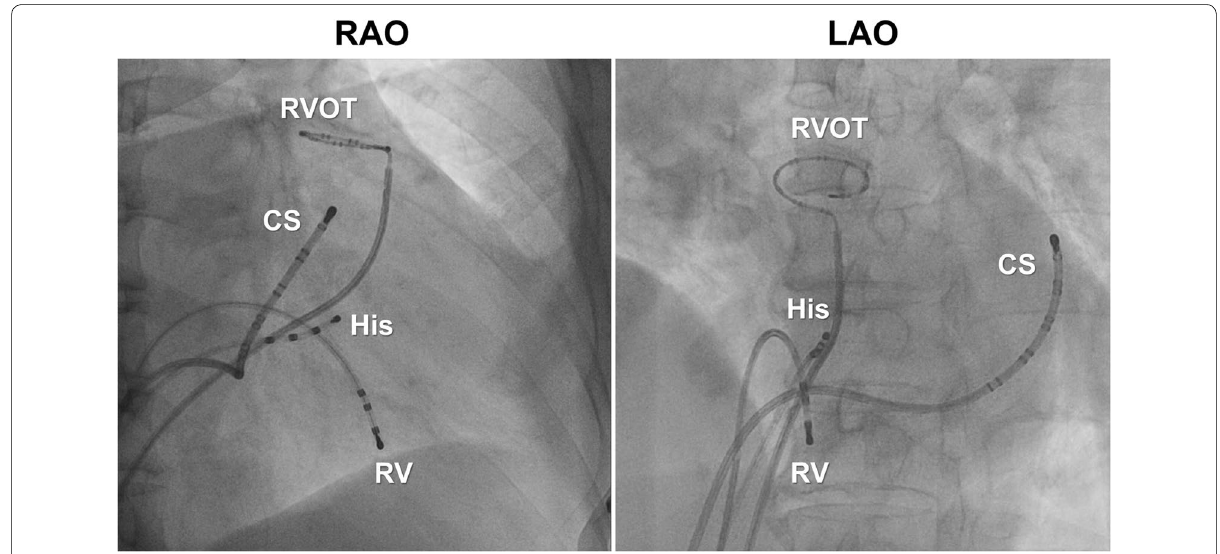
Fig. 1 Fluoroscopic images exhibiting the location of catheters used for the mapping of outflow tract ventricular arrhythmia. CS coronary sinus, His His bundle, RV right ventricle, RVOT right ventricular outflow tract, LAO left anterior oblique view, RAO right anterior oblique